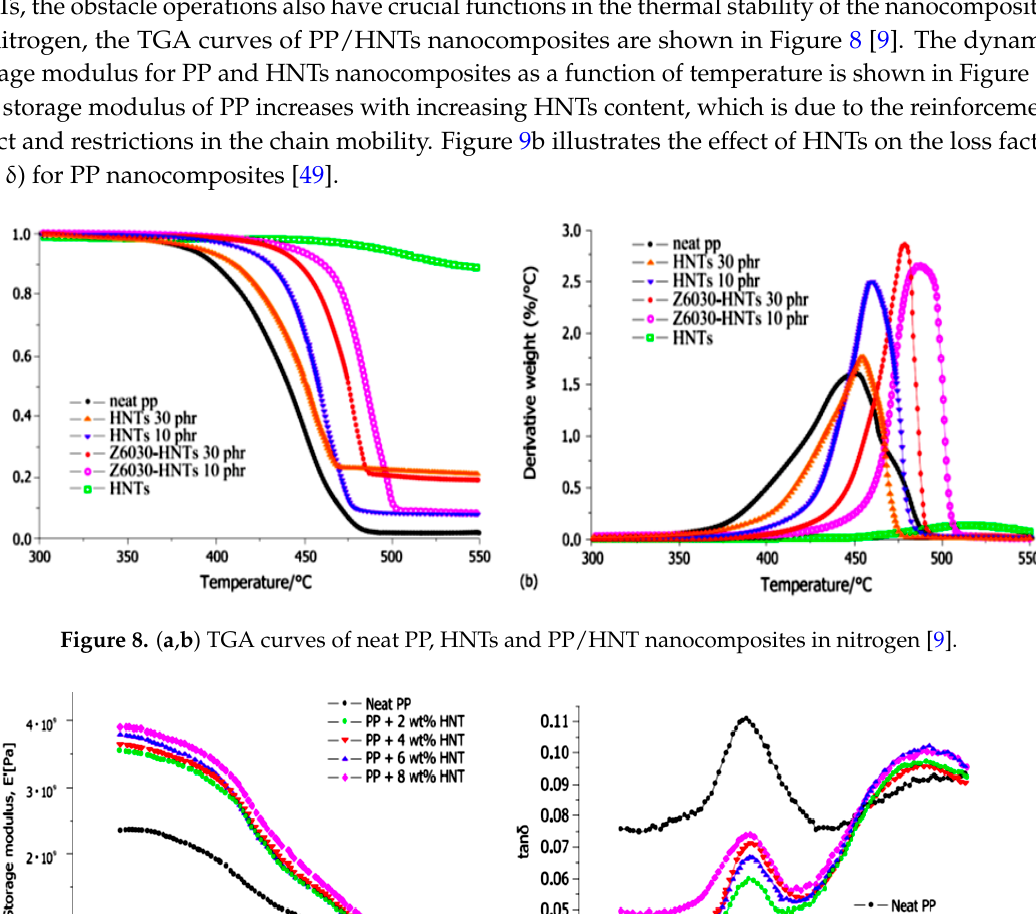
Figure 9. ( a ) Storage modulus ( E' ) and ( b ) Tan δ with temperature sweep as a function of nanotube content for PP/HNT nanocomposites [49].